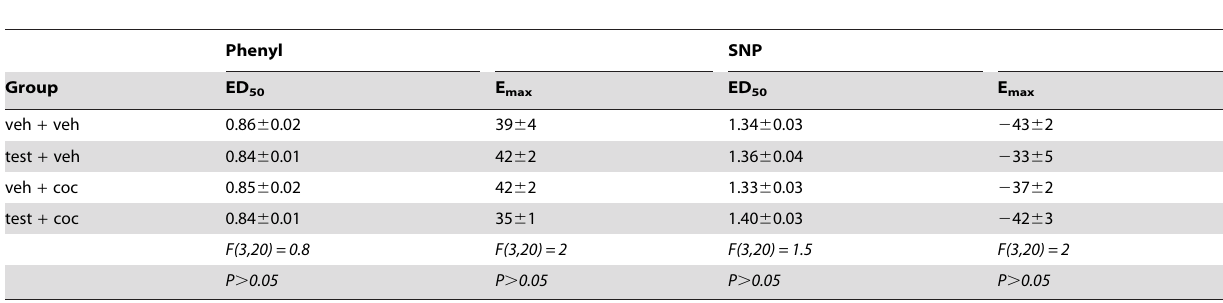
Table 3. Maximal effect (E max ) and dose at 50% of the MAP range (ED 50 ) for phenylephrine (Phenyl) and sodium nitroprusside (SNP) dose-response curves in adolescent animals subjected to treatment with testosterone and cocaine alone and in combination for 10 consecutive days.